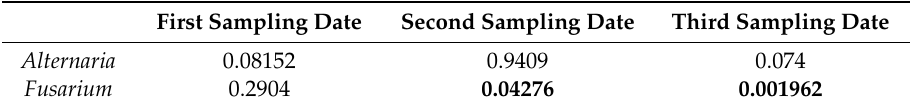
Figure 4. Boxplots representing the values of counted spores per point at different heights sampled at the three different sampling dates. At 90 cm three traps were placed: “90 cm A” were tilted 45 ◦ C, “90 cm B” were against the wind direction (therefore more spores expected), while “90 cm C” were placed hidden from wind. Outliers were omitted due to readability issues. In panel A, a bigger scale is used. In panel B, the same data as 90 cm A, B and C was plotted at a smaller scale, for improving the readability. Table 3. p -values of the paired t -test between the number of spores counted on 90 cm B spore traps (against wind) and 90 cm C (hidden from wind). Paired samples were coming from the same sampling point. The three sampling dates were tested separately. In bold are the statistically significant p -values ( p <